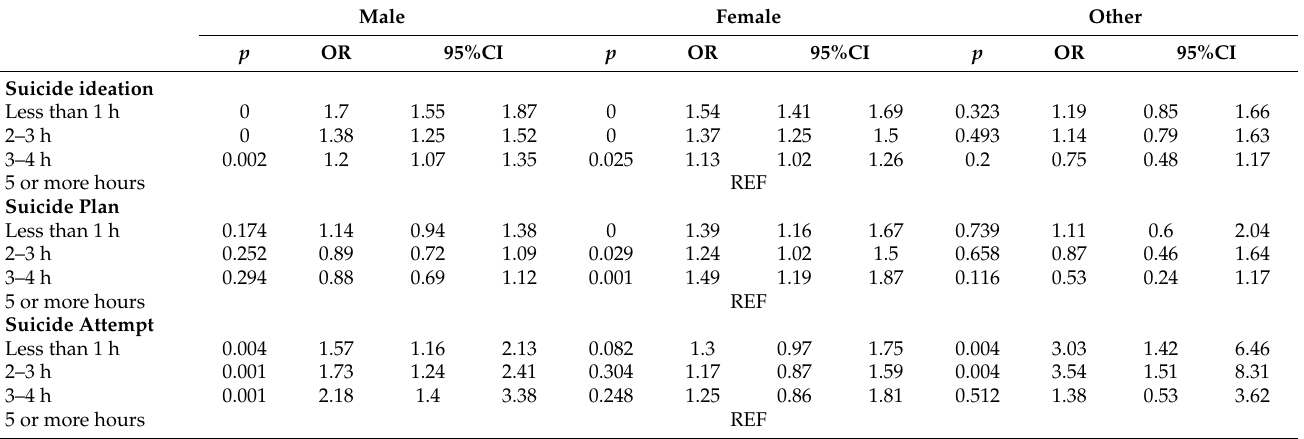
Table 3. Association between exercise with suicide ideation and plan in the sample by gender (triple category).